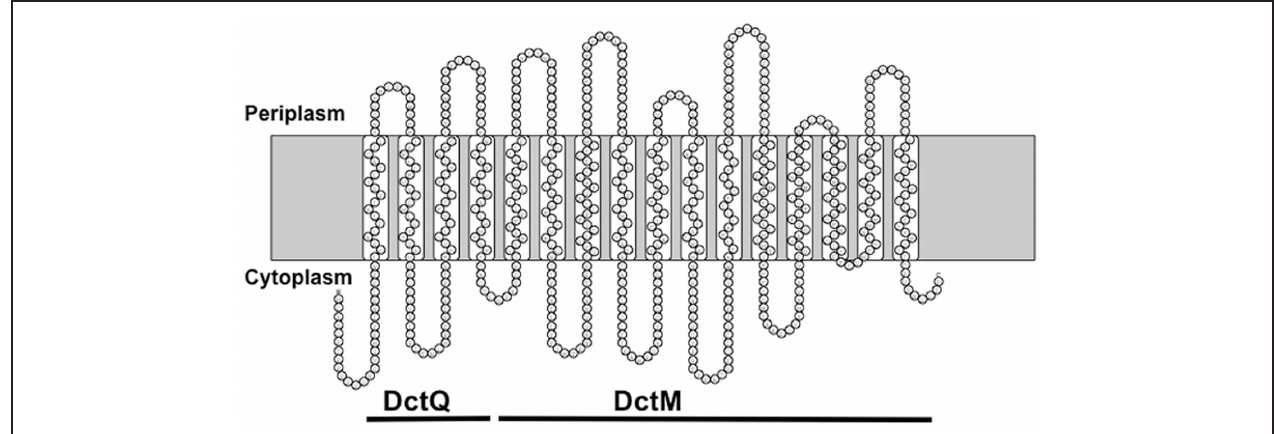
FIGURE 3 | A diagram showing the transmembrane loops of SiaT based on a hydrophobicity plot. The regions corresponding to DctQ and DctM are shown. Model based on prediction program at